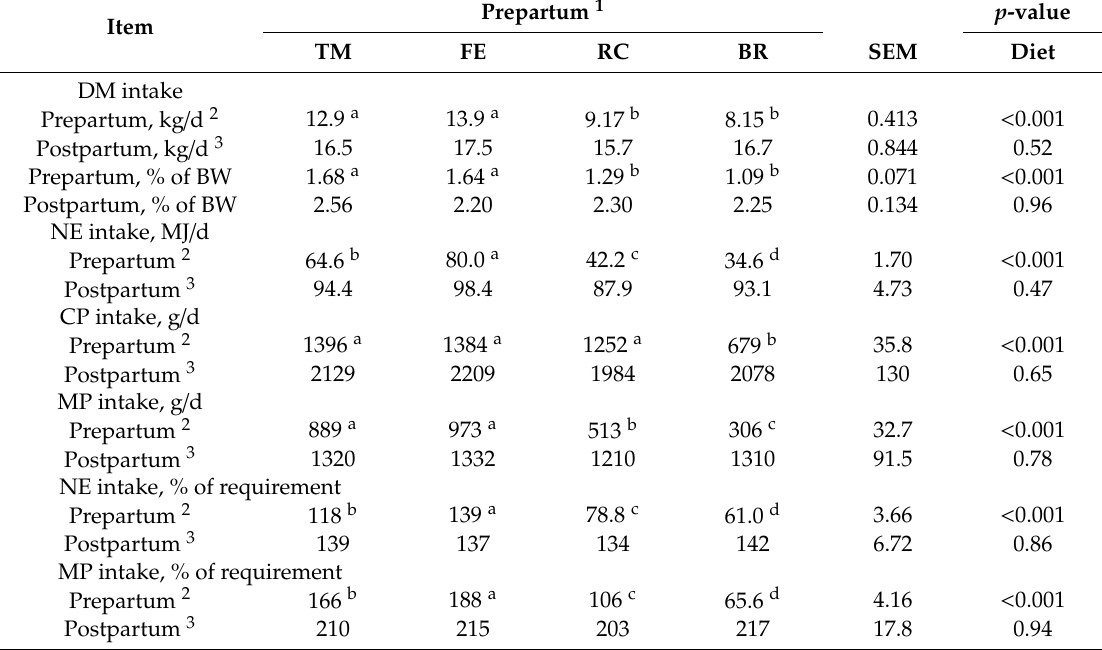
Table 2. E ff ects of prepartum and postpartum experimental diets on daily intakes of dry matter (DM), net energy (NE), crude protein (CP) and metabolizable protein (MP), and intake of NE and MP in relation to requirements [24] in gestating beef